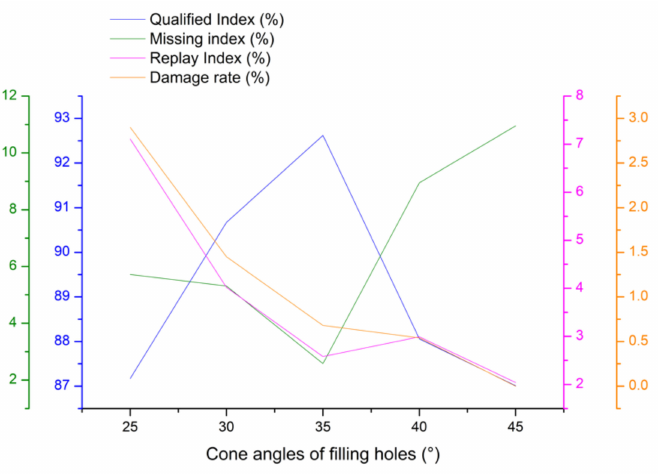
Figure 10. The relation curve between cone angles of filling hole and seed